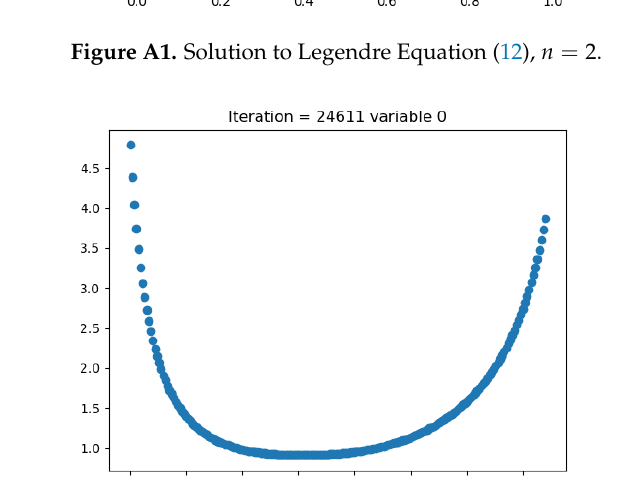
Figure A1. Solution to Legendre Equation (12), n = 2.